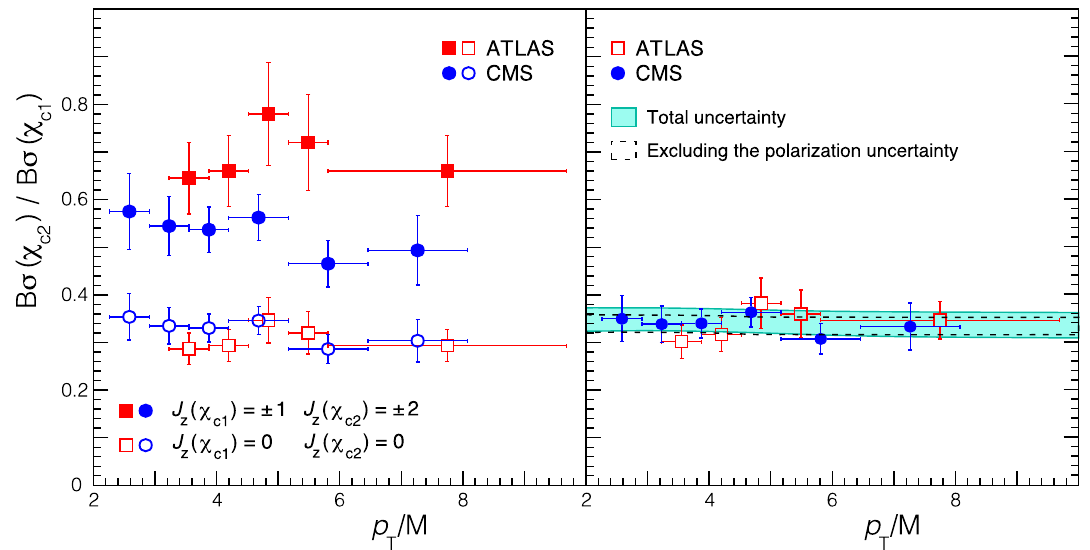
Fig. 6 Ratio between the χ c 2 and χ c 1 cross sections, times the corresponding χ cJ → J /ψ γ branching fractions, as a function of p T / M , for two extreme polarization scenarios (left) and for the polarizations determined in our global-fit analysis (right) difference between the widths of the filled and dashed bands reflects the residual polarization uncertainty, a rather small effect in comparison with the impact seen in the left